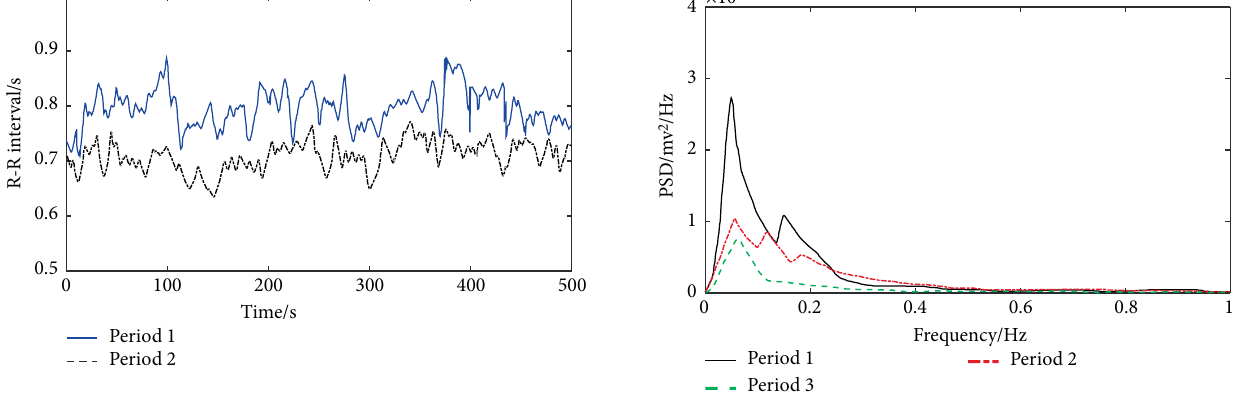
Figure 8: Comparison of HRV-PSD (single driving vs. master-slave task).